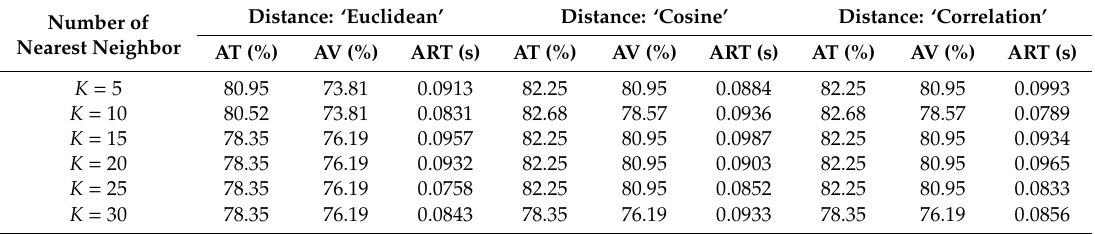
Table 2. The parameter settings and performance of k-nearest neighbor (KNN). AT, accuracy in training sets; AV, accuracy in validation sets; ART, average response time.